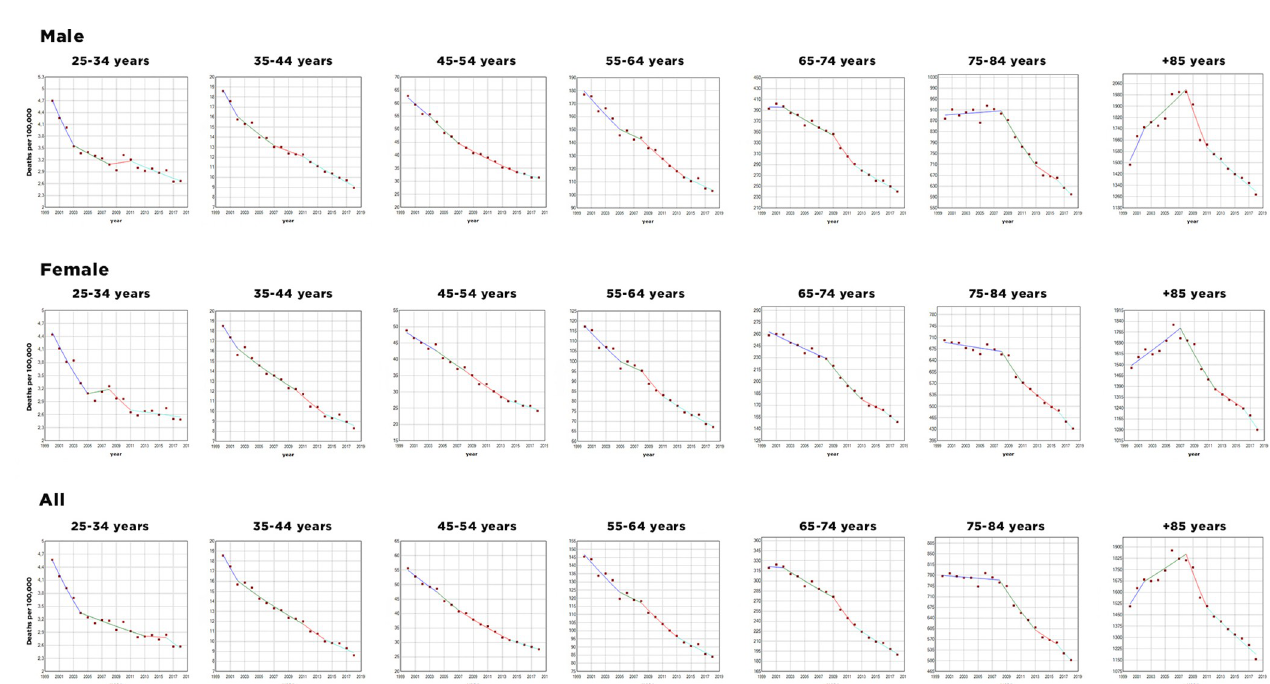
Fig 3. Trends in age and sex-specific mortality rates per 100,000 for stroke, Brazil. 2000–2018.